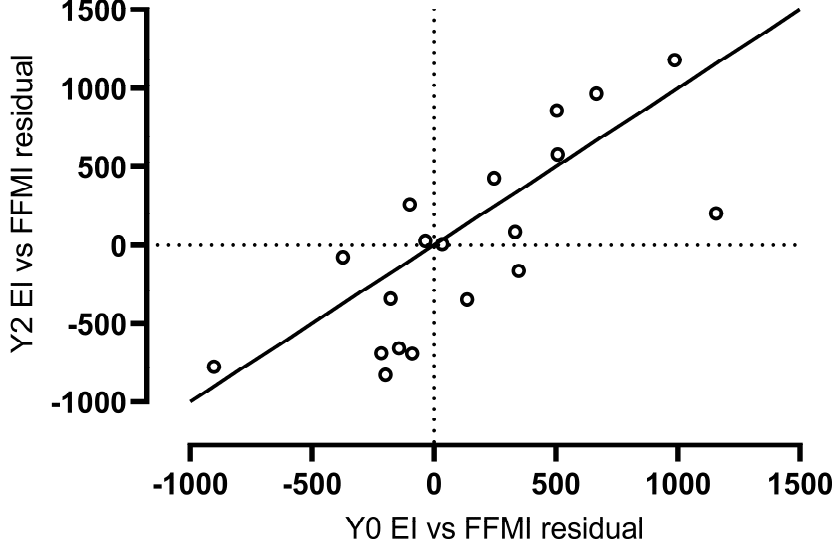
Figure 2. Association between energy intake (adj. for FFMI) at Baseline and Year 2 (ICC = 0.84), depicted against a line of identity (solid line). Abbreviations: energy intake, EI; fat-free mass index, FFMI; intra-class correlation, ICC; baseline, Y0; year 2, Y2.